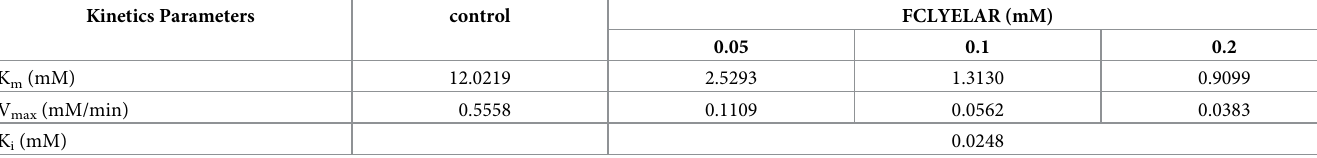
The results are findings are expressed in the form of mean ± SEM (n = 3)